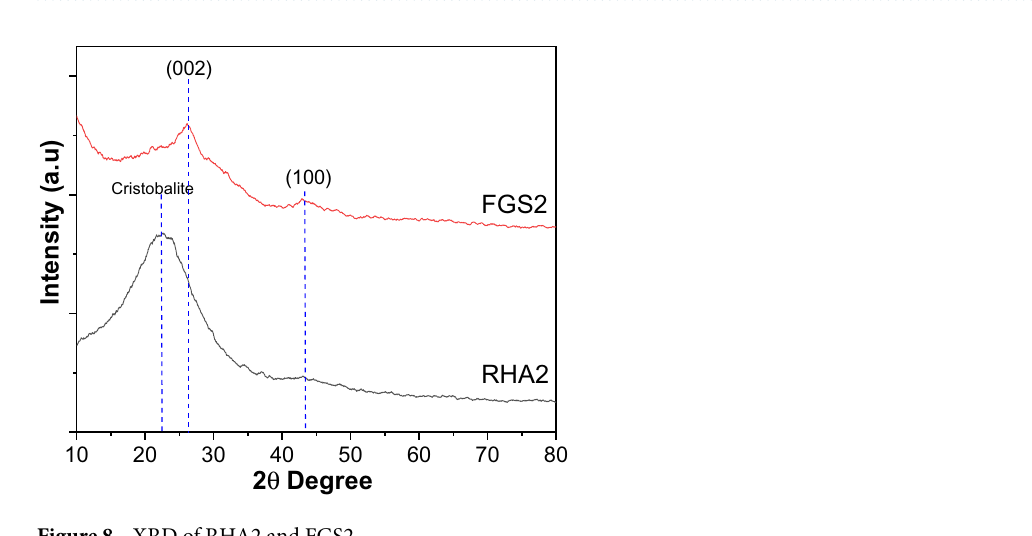
Figure 8. XRD of RHA2 and